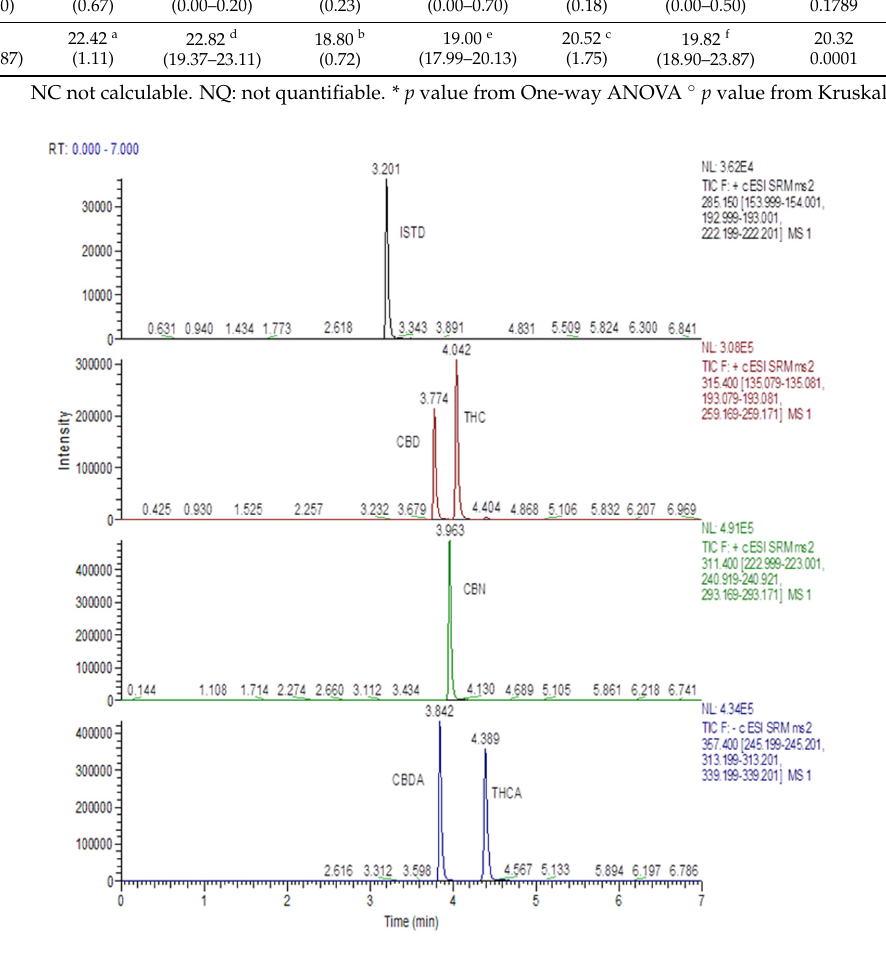
Figure 1. HPLC-MS/MS mass chromatogram of a standard calibration point for analytes involved in the study.